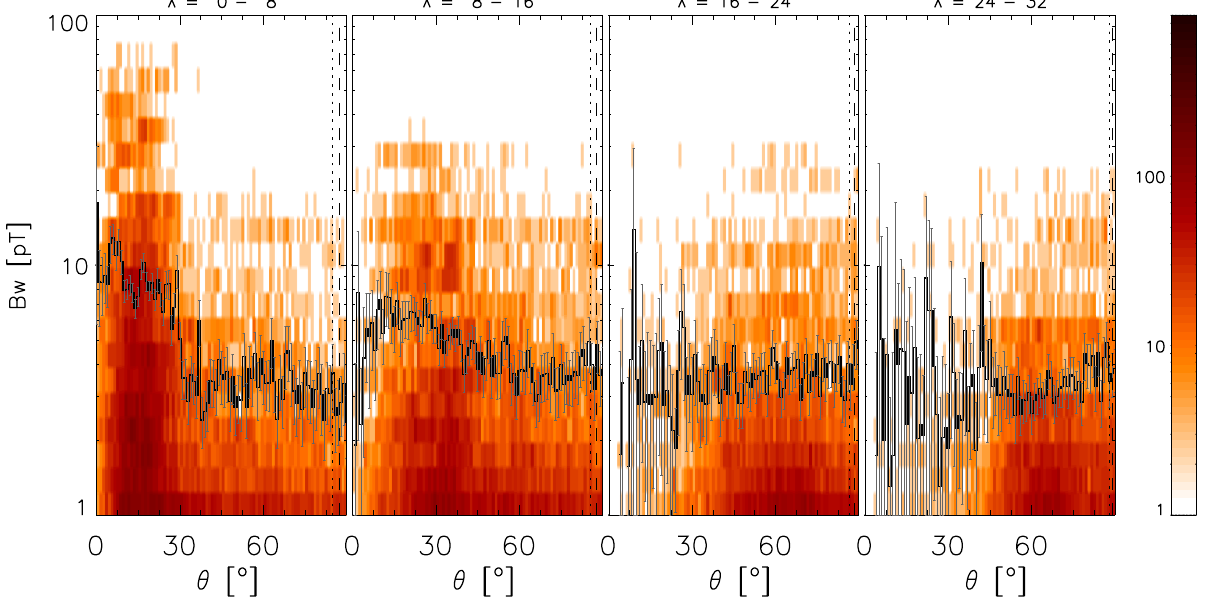
Fig. 3. Distribution of hiss amplitudes in four ranges of magnetic latitude for 2 < L < 2 . 5 on the dayside when Kp < 3. Black curves show rms levels corresponding to average